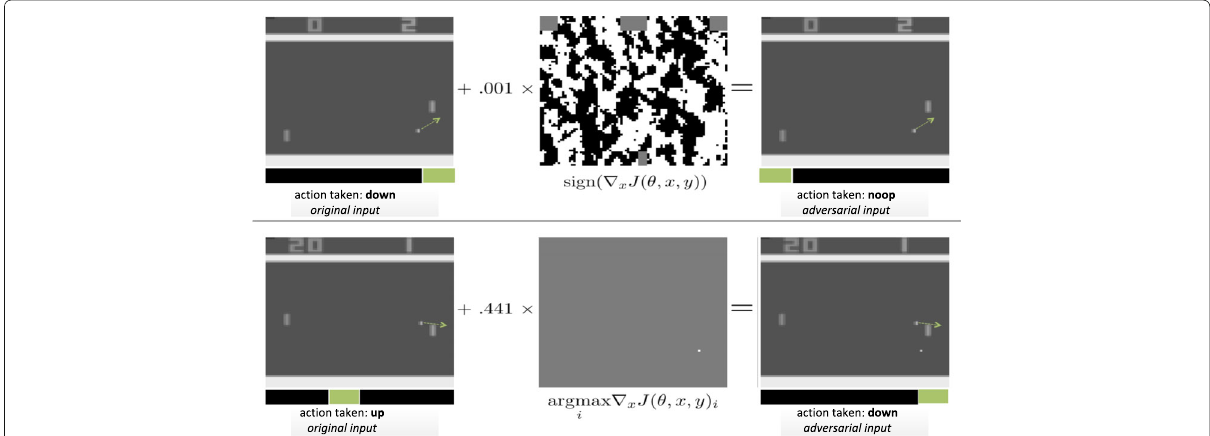
Fig. 2 Examples for adversarial attacks on Pong policy trained with DQN(Huang et al. 2017). The first line: computing adversarial perturbations by fast gradient sign method (FGSM)(Goodfellow et al. 2014a) with an ℘ ∞ -norm constraint. The trained agent who should have taken the “down” action took “noop” action instead under adversarial attack. The second line: authors utilized the FGSM with ℘ 1 -norm constraint to compute the adversarial perturbations. The trained agent can not take action correctly, which should have moved up, but took “down” action after interference. Videos are available at